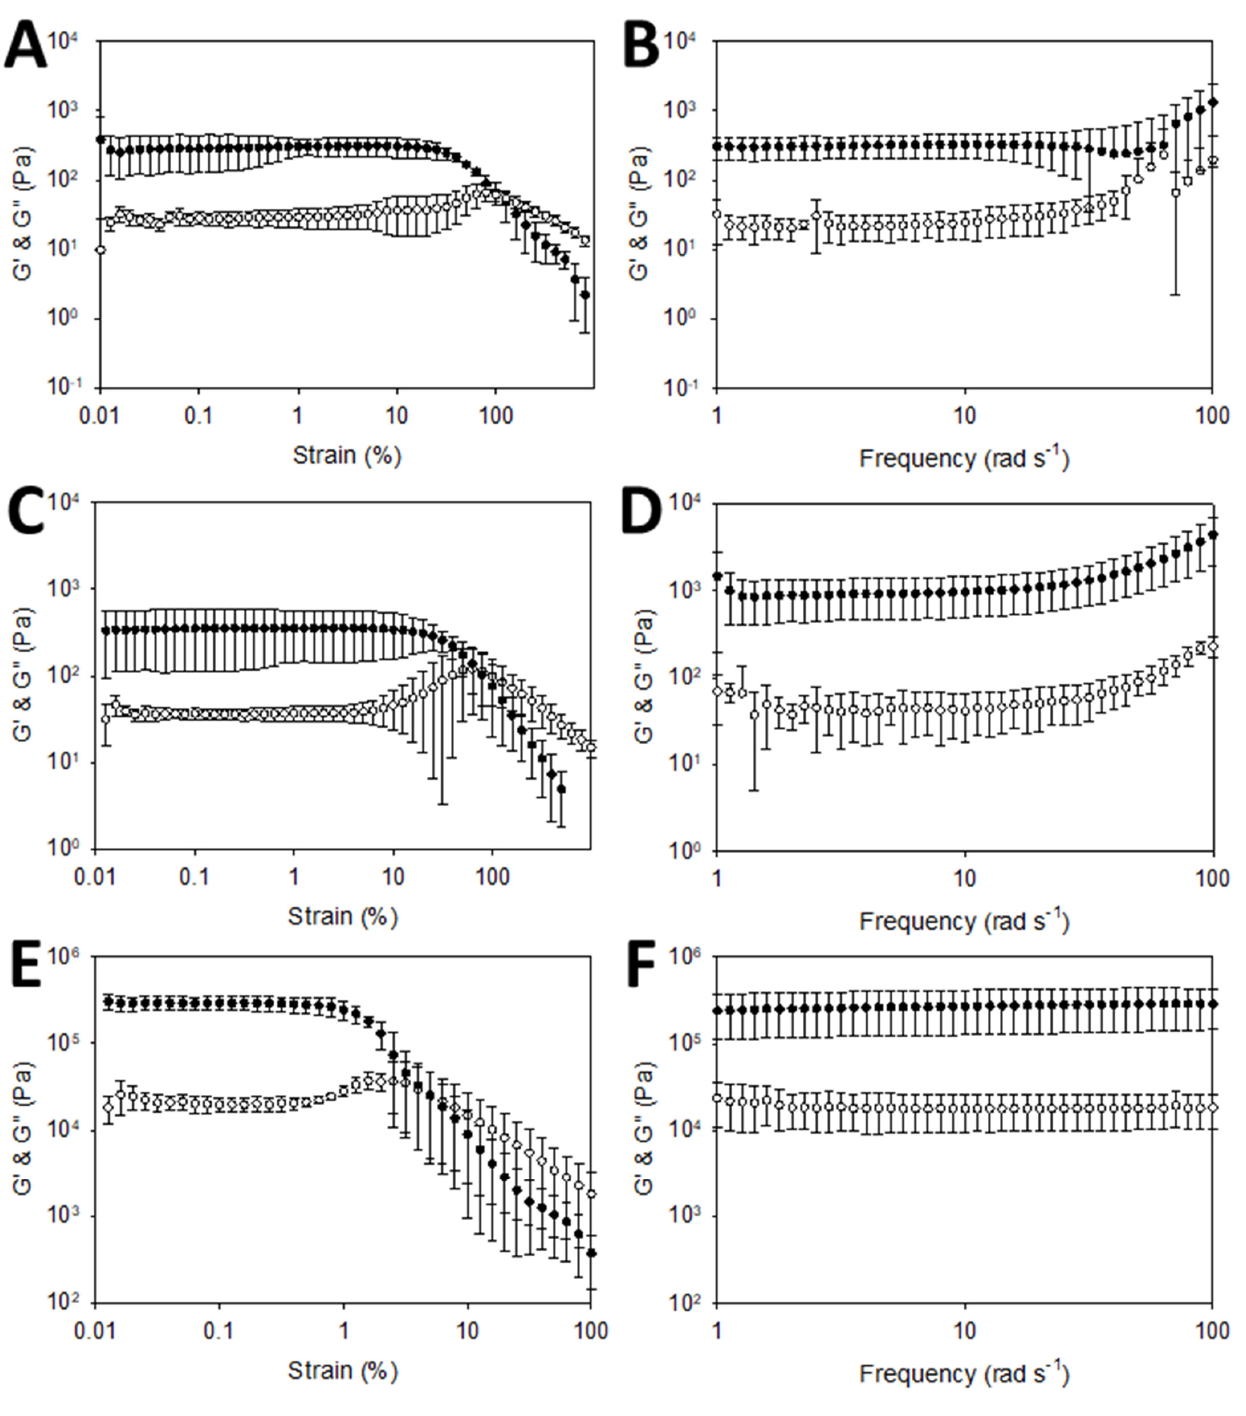
Figure 6. Rheology data. ( A ) strain sweep: non-conductive hydrogels (wet). ( B ) Frequency sweep: non-conductive hydrogels (wet). ( C ) strain sweep: conductive hydrogels (dry). ( D ) Frequency sweep: non-conductive hydrogels (dry). ( E ) strain sweep: conductive hydrogels (wet). ( F ) Frequency sweep: conductive hydrogels (wet).